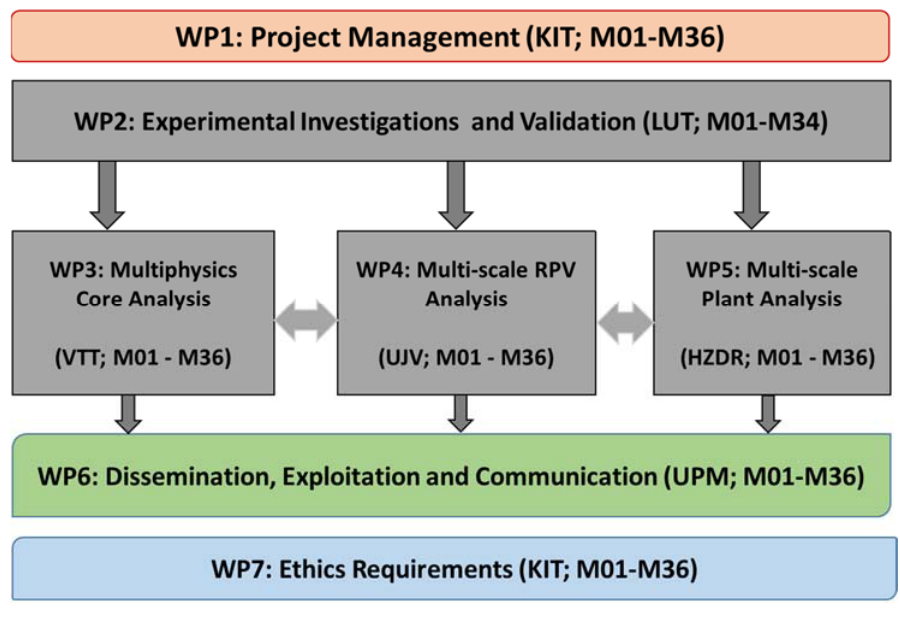
Figure 2. McSAFER work packages and their interactions.